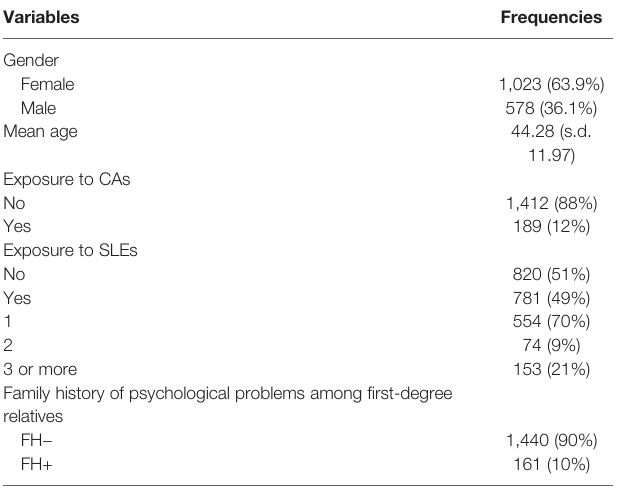
TABLE 1 | Summarized frequencies of demographic and independent variables.